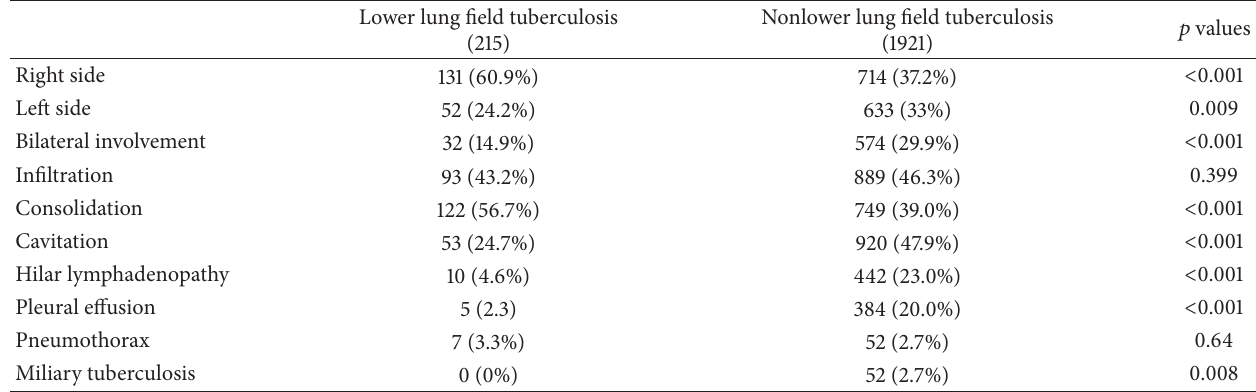
Table 2: Comparison of radiological features in two